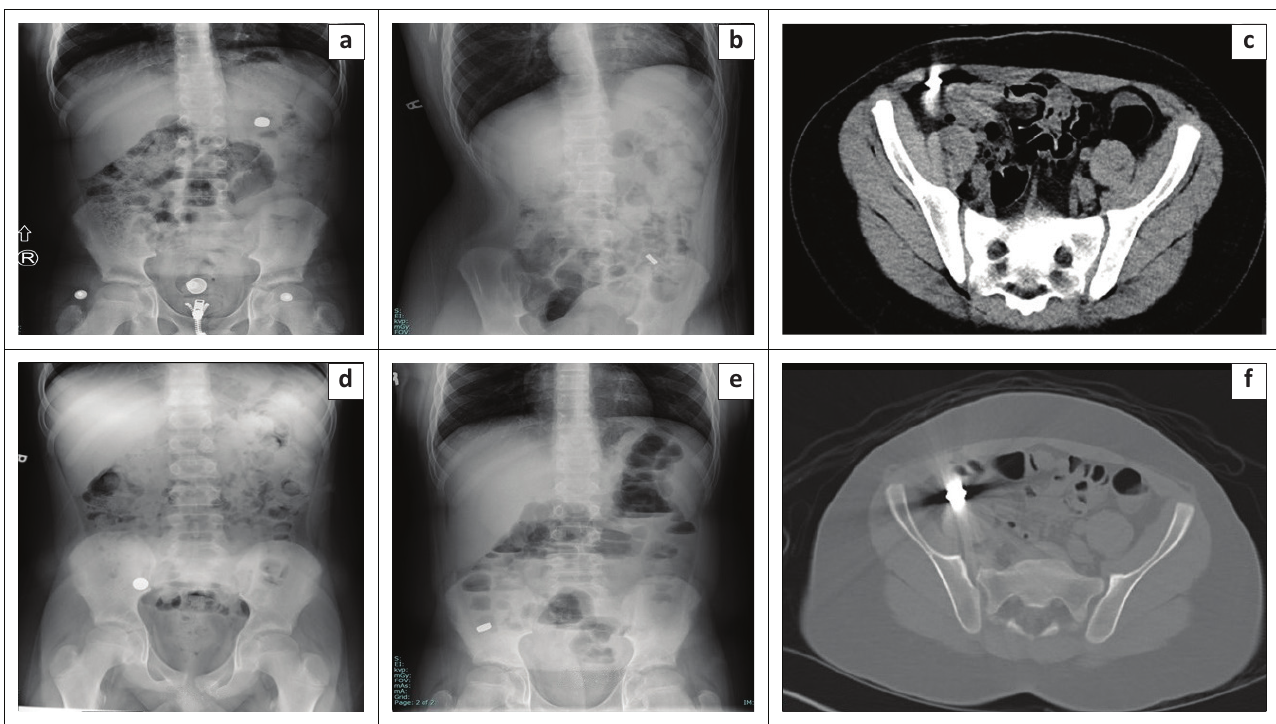
FIGURE 5: Serial abdominal radiographs and computed tomography (CT) images of a 12-year-old asymptomatic male child who swallowed five small magnets, shows the magnets initially in (a) the stomach, (b) then in the left lower quadrant and (c, d and e) later in the right lower quadrant. The multiplicity of magnets can be better appreciated on CT (c and f). The magnets were subsequently removed by